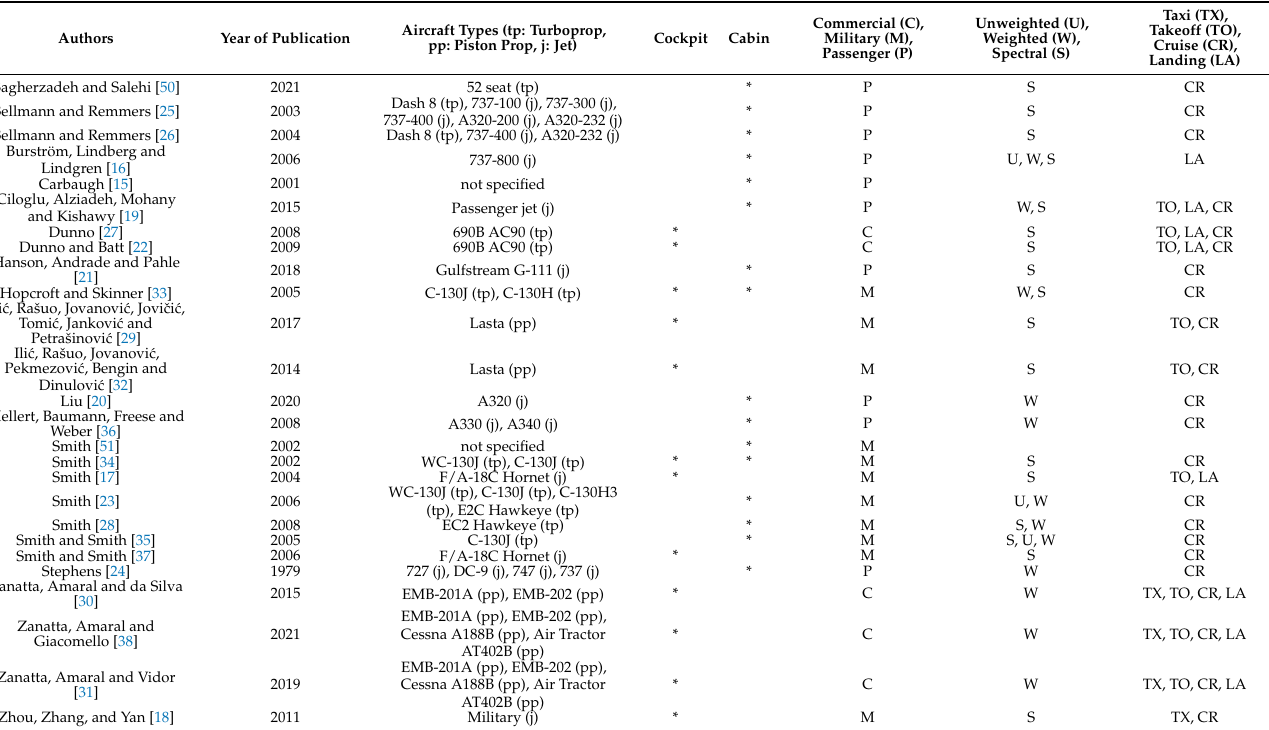
Table A1. Summary of Papers Reviewed after Online Database Search and Screening Review Includ- ing Aircraft Type, Measurement Location, Flight Phase, Reported Data, and Aircraft Typical